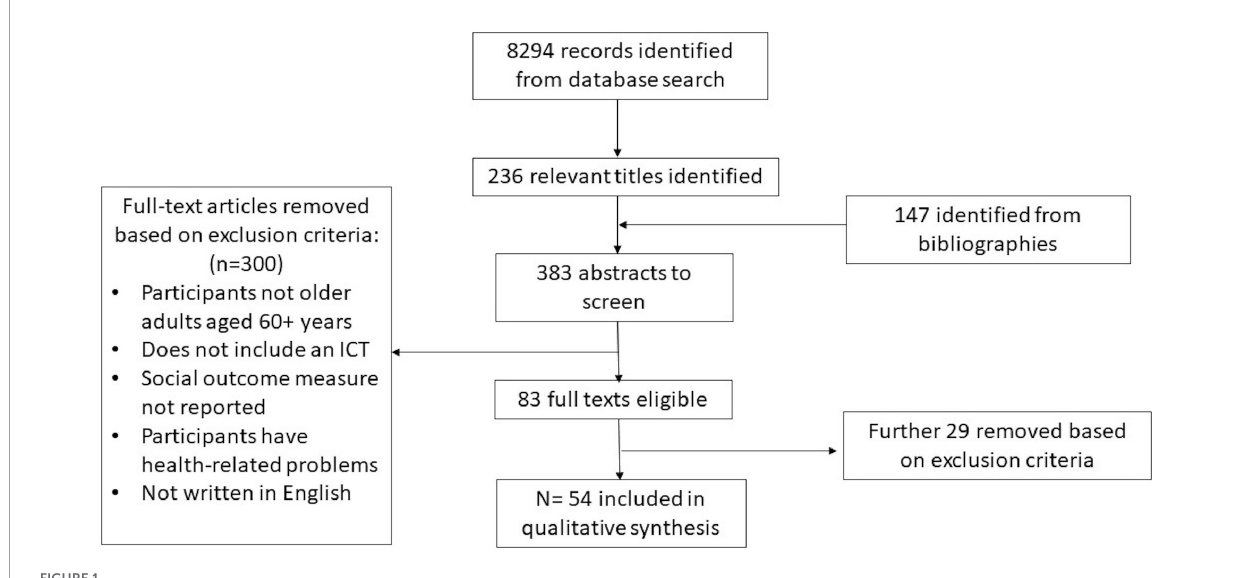
FIGURE1 Article screening